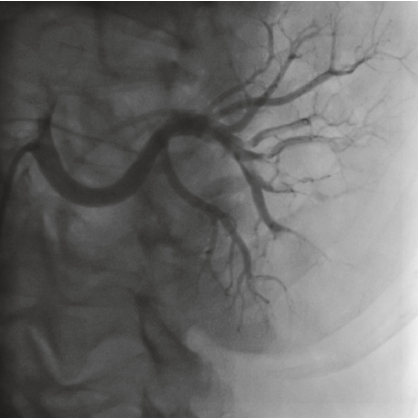
Figure 2: Second renal artery angiography showing residual throm- boembolic materials in the left renal artery branches.